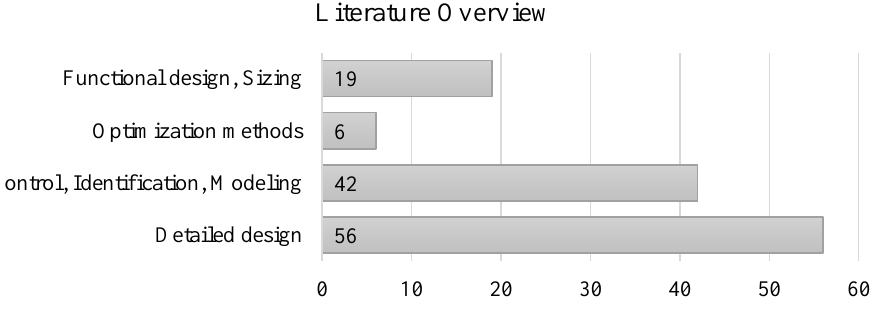
Figure 1. Distribution of the analyzed papers among the identified categories according to the proposed classification.